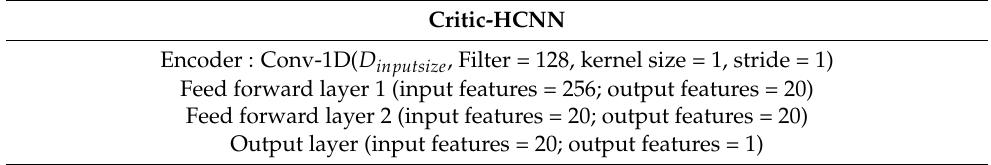
Table 5. Main parameters of the critic